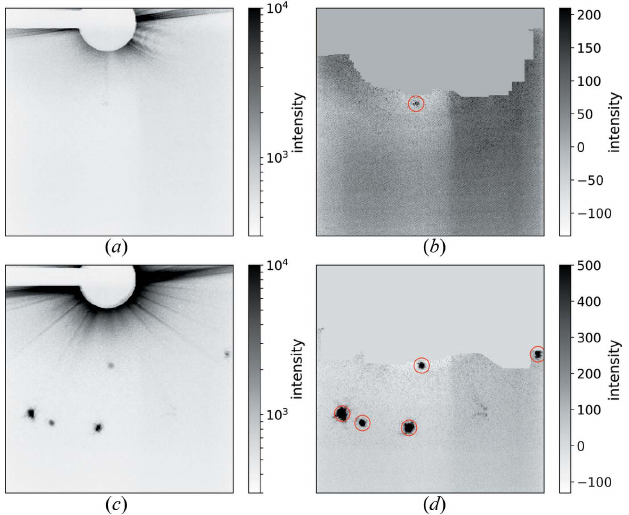
Figure 3 Example diffraction patterns recorded with one pulse ( a ) and ( b ), and 20 pulses ( c ) and ( d ), each at a fluence of 0.5 (cid:8) 0.3 m J m m (cid:2) 2 . Panels ( a ) and ( c ) display the raw images on a logarithmic gray scale and ( b ) and ( d ) show the corrected images on a linear gray scale after background subtraction, masking of jet streak, and identification of the peaks. The peak locations are indicated by red circles. Panels ( a ) and ( b ) show a typical pattern with one very weak peak whereas ( c ) and ( d ) show a strong pattern with multiple peaks from different crystals recorded in the course of the pulse train. One peak from the 100 class of Bragg reflections and multiple peaks from the 110 class were found. Based on the angle between some of the 110-peaks and the beam center, these cannot originate from the same crystal lattice.